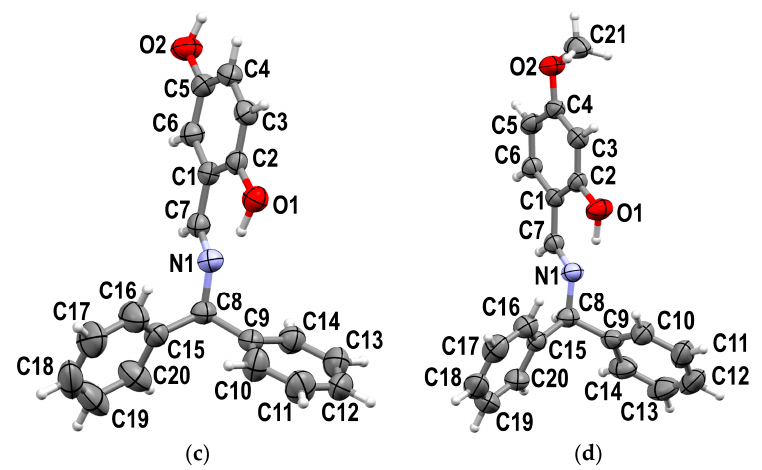
Figure B1. Thermal ellipsoids (50%) plots of ( a ) oOHsaladpm , ( b ) mOHsaladpm , ( c ) pOHsaladpm and ( d ) mvanadpm showing atom-labelling schemes. H atoms are shown as small spheres of arbitrary radius.